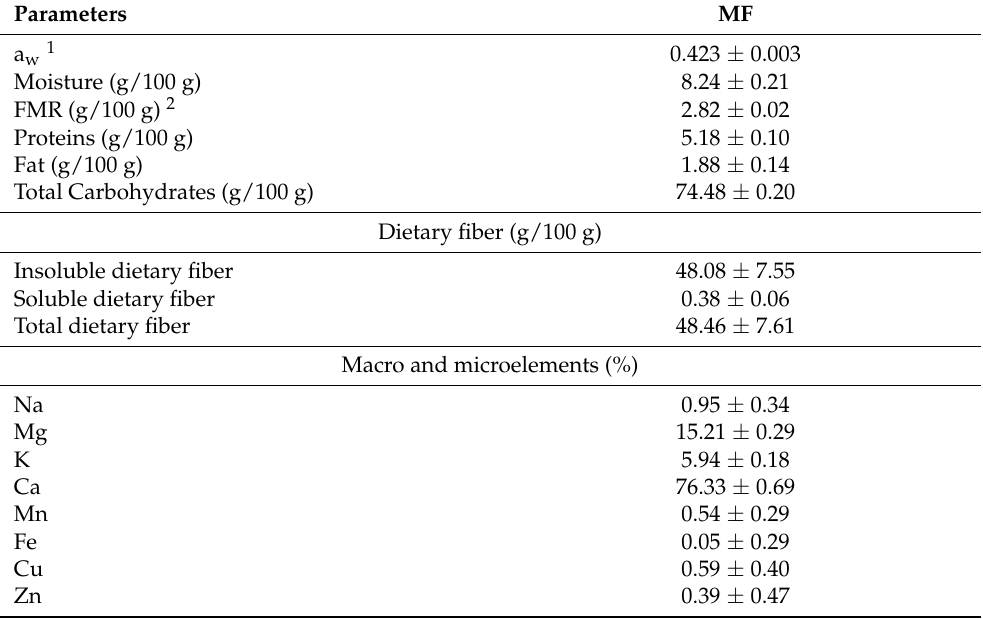
Table 2. Physicochemical composition, dietary fiber content and mineral profile (media ± standard deviation, n: 3) of